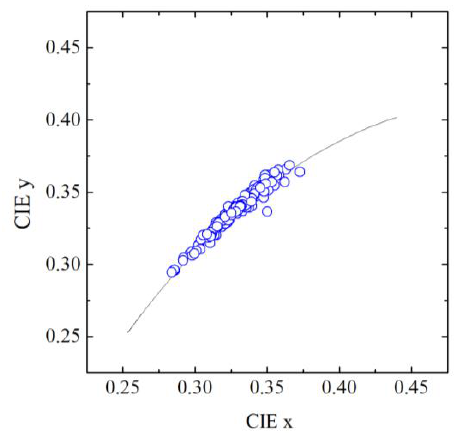
Figure 4. Color of the illumination measured when taking the photos of graffiti (blue symbols). The black line represents the Planckian locus, i.e., the colors of a blackbody with different temperatures, from deep red at low temperatures to bluish white at very high temperatures. The colors of the illumination on graffiti span a considerable range of color temperature corresponding roughly from 5000 K to 10,000 K, expressing different mixtures of skylight and sunlight.